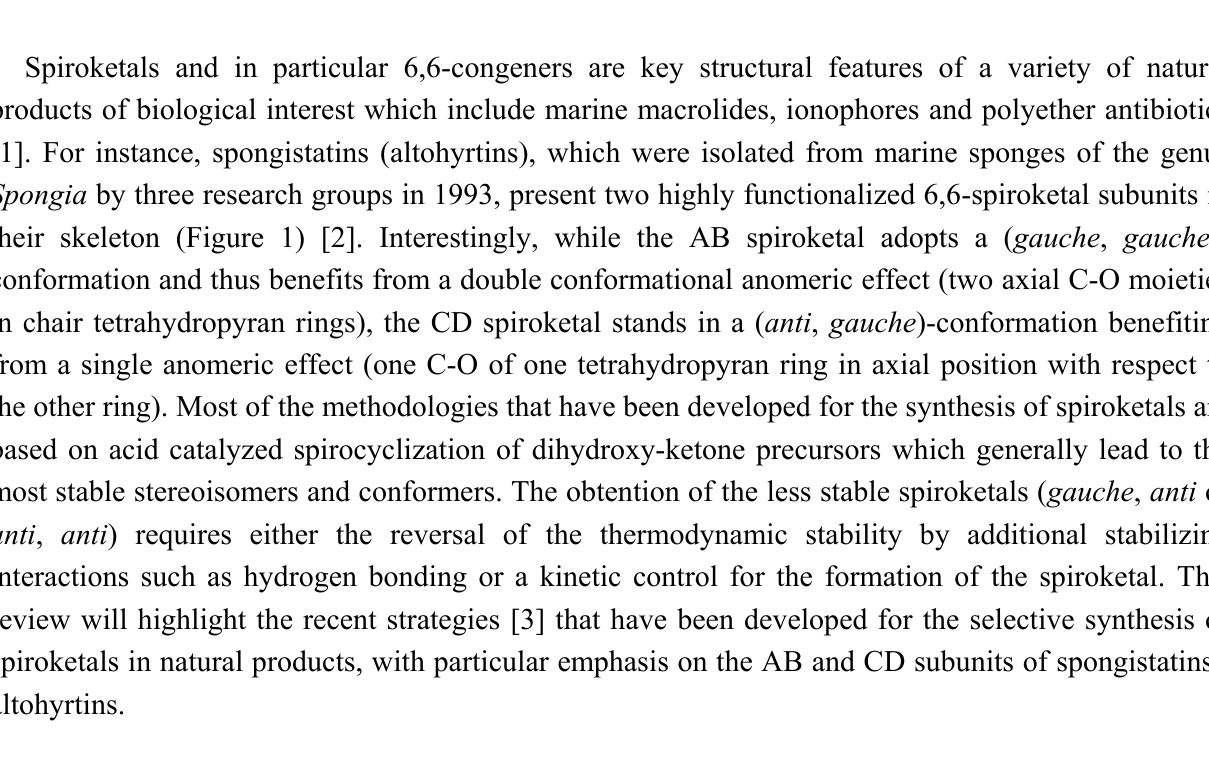
Figure 1. Members of the spongistatins/altohyrtins